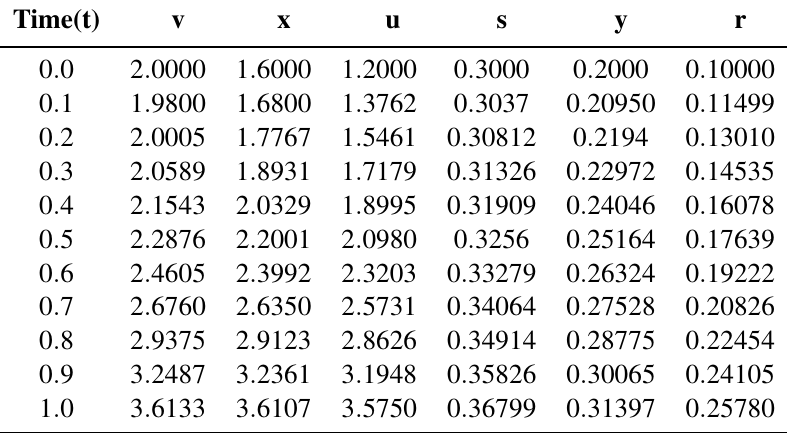
Table 2 Numerical values of Figure